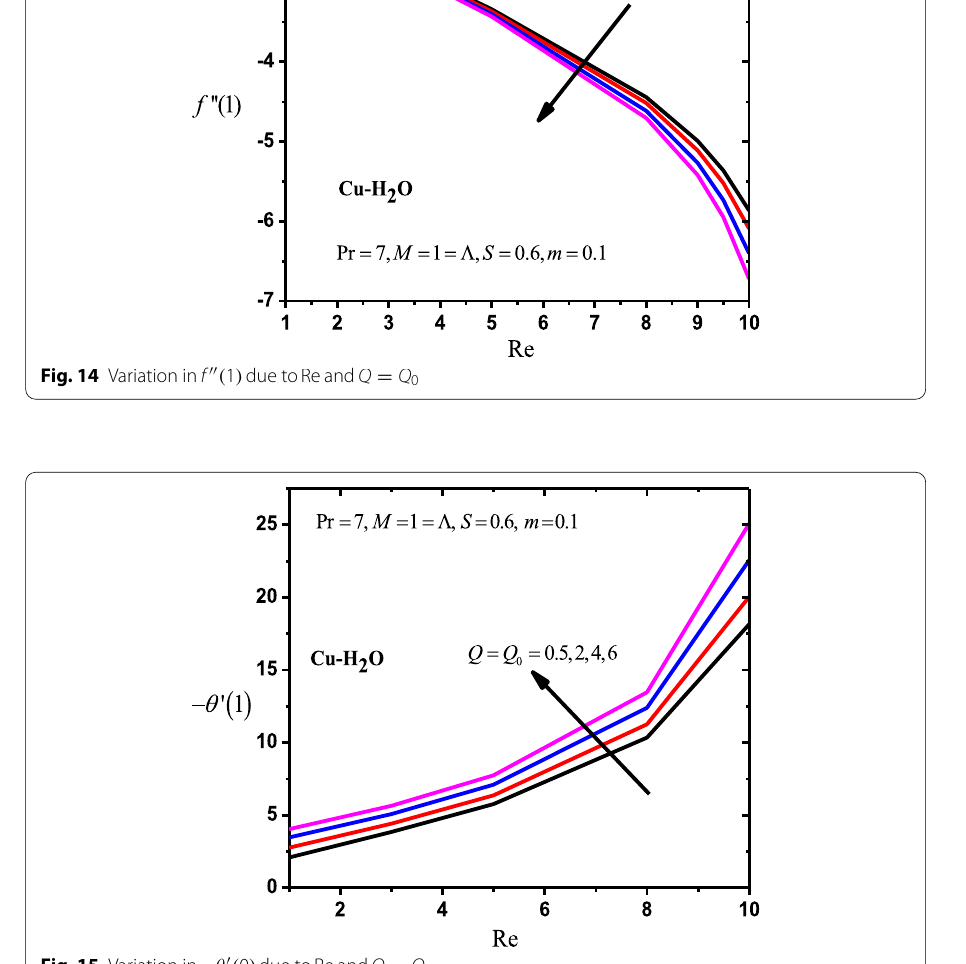
Fig. 15 Variation in